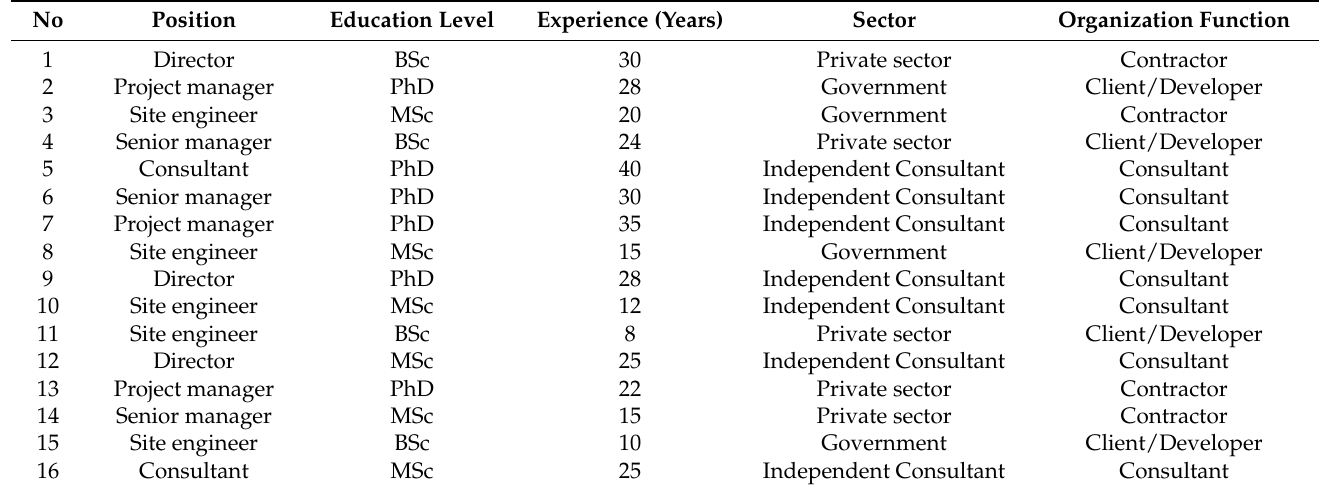
Table 2. The interviewees’